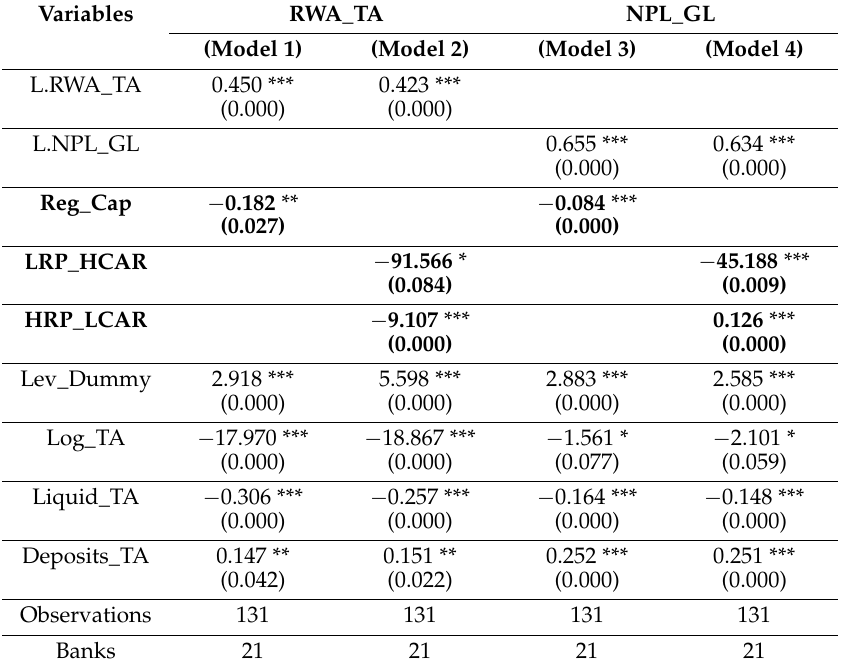
Table 3. Effects of regulatory capital requirements on bank